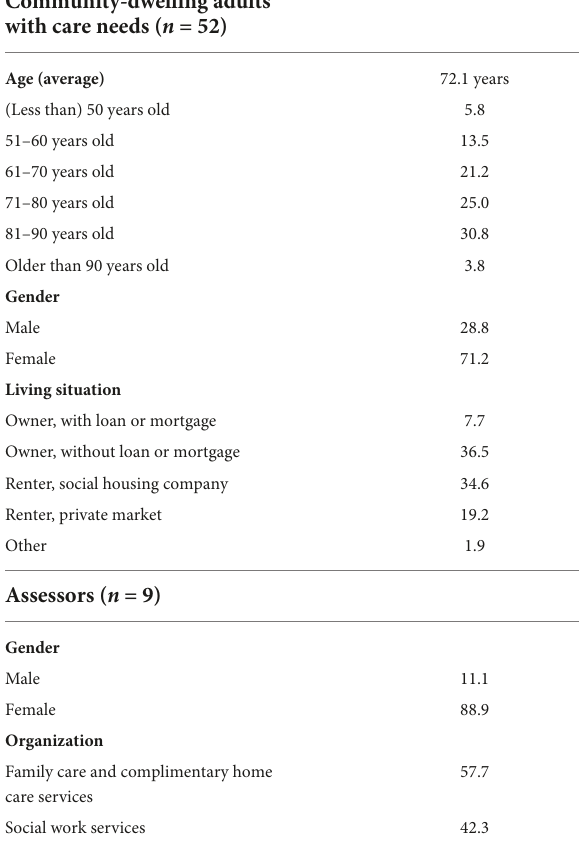
Statistic (mean or